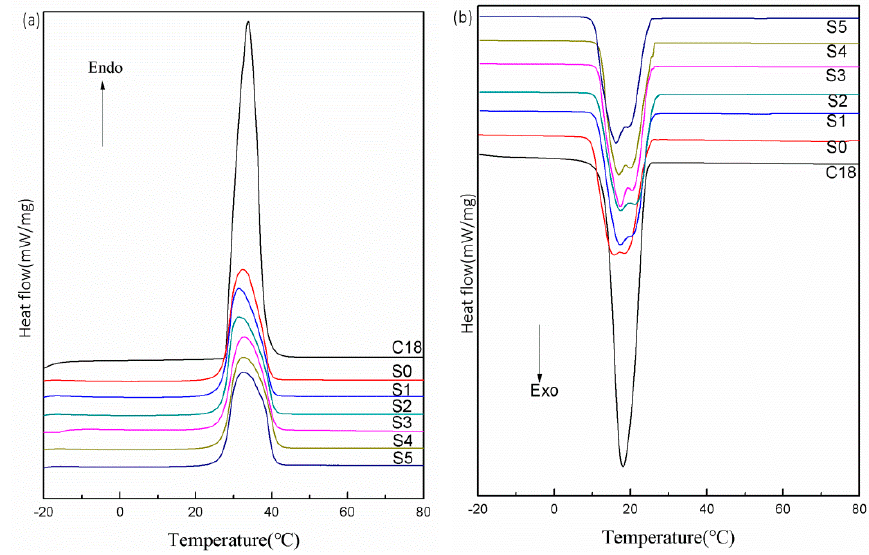
Figure 6. Differential scanning calorimeter (DSC) thermograms of C18, S0, S1, S2, S3, S4, and S5: ( a ) Heating thermograms and ( b ) cooling thermograms.